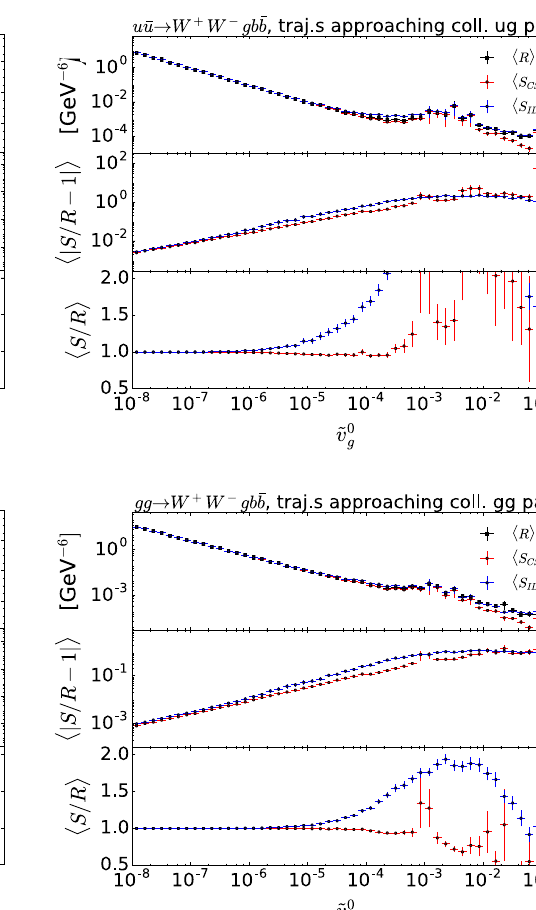
the text. Left: average over trajectories in phase-space with increasingly soft gluon. Right: average over trajectories with increasingly collinear